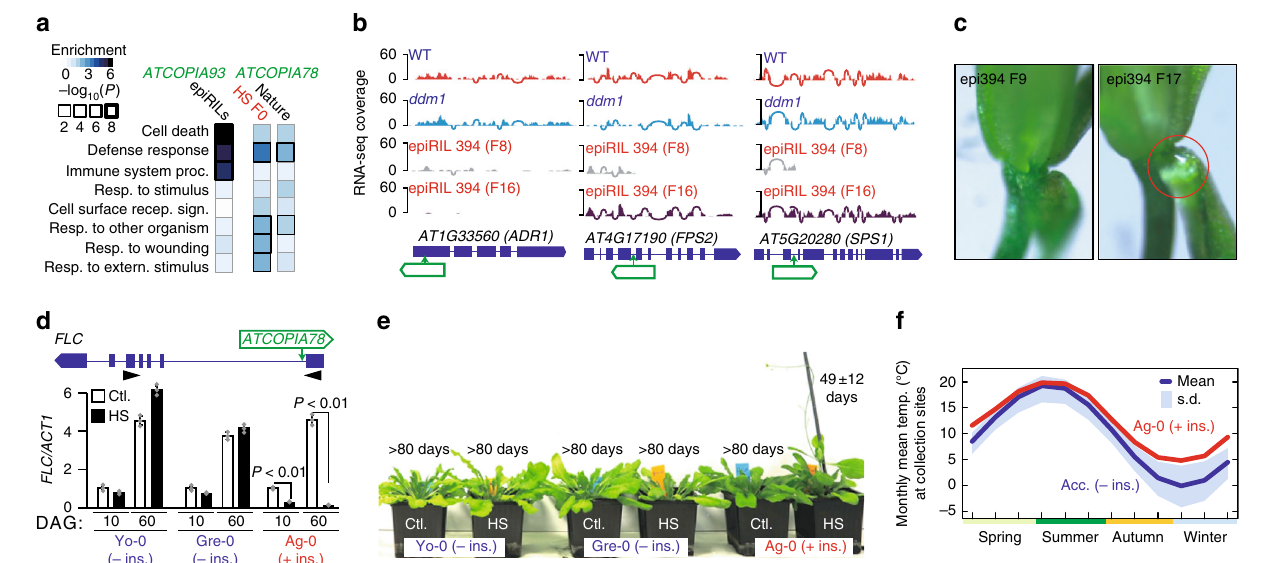
Fig. 5 ATCOPIA preferentially targets environmentally responsive genes. a GO term analysis of genes with ATCOPIA93 or ATCOPIA78 insertions in the epiRILs or other experimental settings, or in nature. b Genome browser view of RNA-seq coverage of three genes hit by ATCOPIA93 in epiRIL394. c . Nectar secretion in fl owers of epiRIL394 at F9 and F17. A nectar droplet is only observed at F17 (circle). d Structure of the FLC locus with the position of the ATCOPIA78 insertion in accession Ag-0 (top). Relative expression level of FLC at 10 and 60 days after germination (DAG) in plants containing (red) or lacking (blue) the ATCOPIA78 insertion and grown under control conditions (ctl.) or subjected to heat stress (HS) at the seedling stage (bottom). Data are mean ± s.d. ( n > 9 independent samples, one biological experiment) and statistical signi fi cance for differences was obtained using the MWU test. e . Flowering time (mean ± s.d.; n > 9 independent samples, two independent experiments) for the same plants as in d . f Monthly mean temperature at collection sites for Ag-0 and 25 accessions sharing the same FLC haplotype but lacking the ATCOPIA78 insertion. Source data of Figure panels d and e